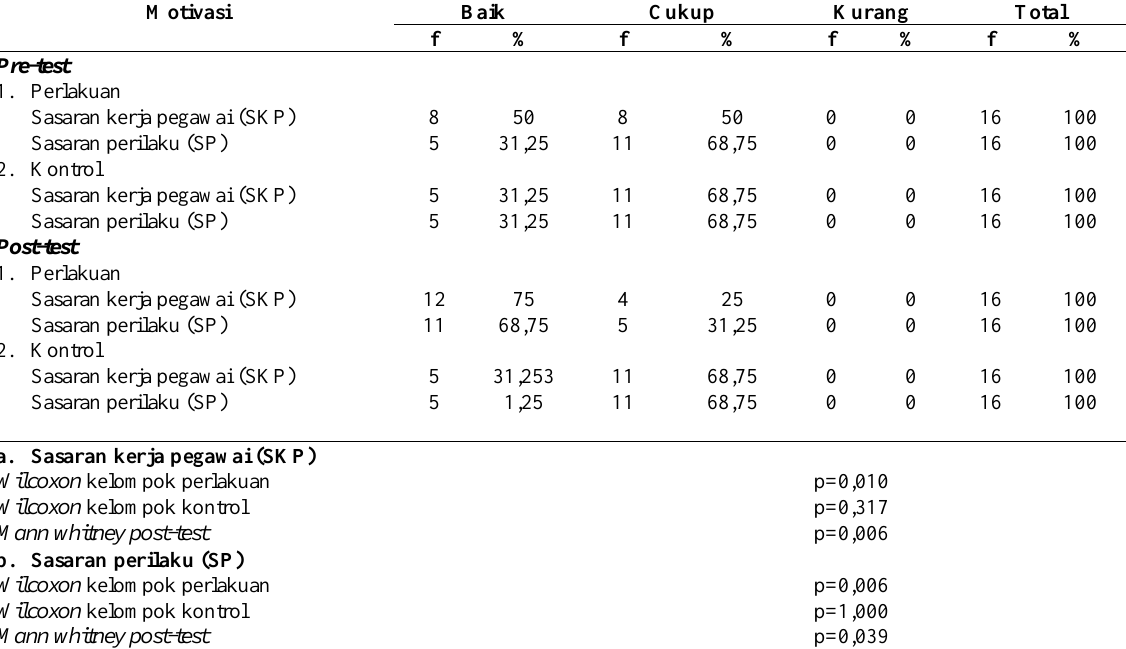
Tabel 8. Distribusi frekuensi kinerja perawat pelaksana pada kelompok perlakuan dan kontrol